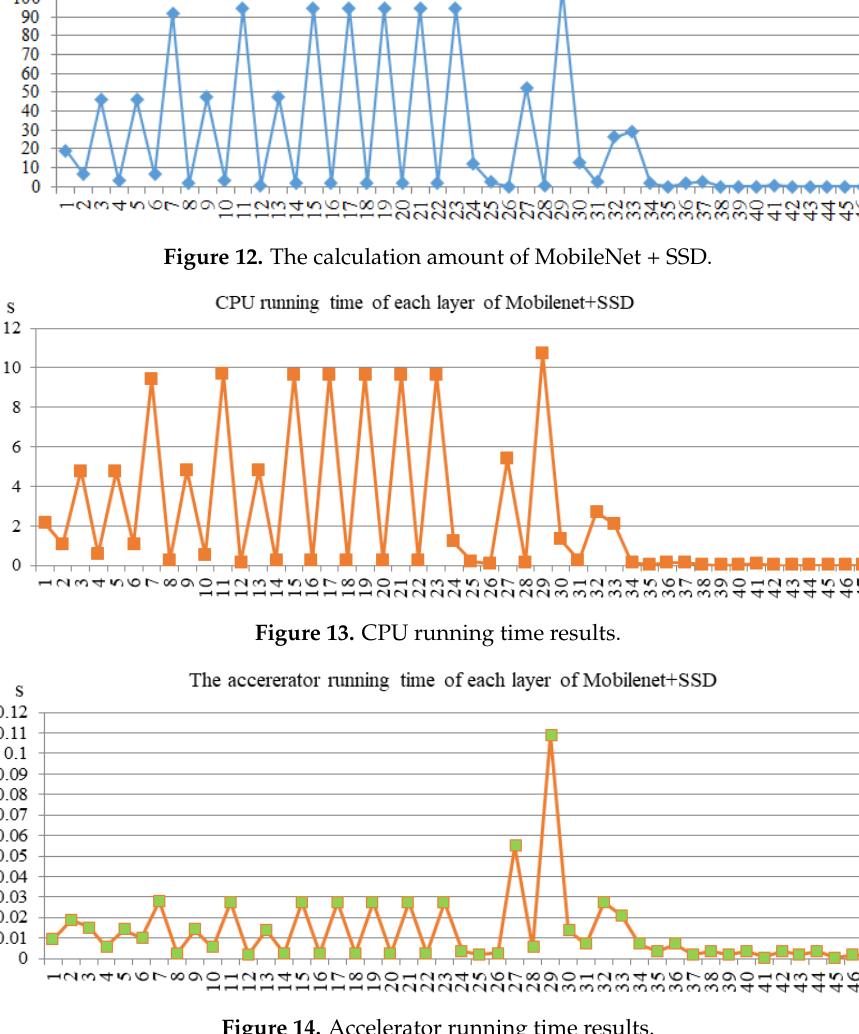
Table 6. Comparison to previous